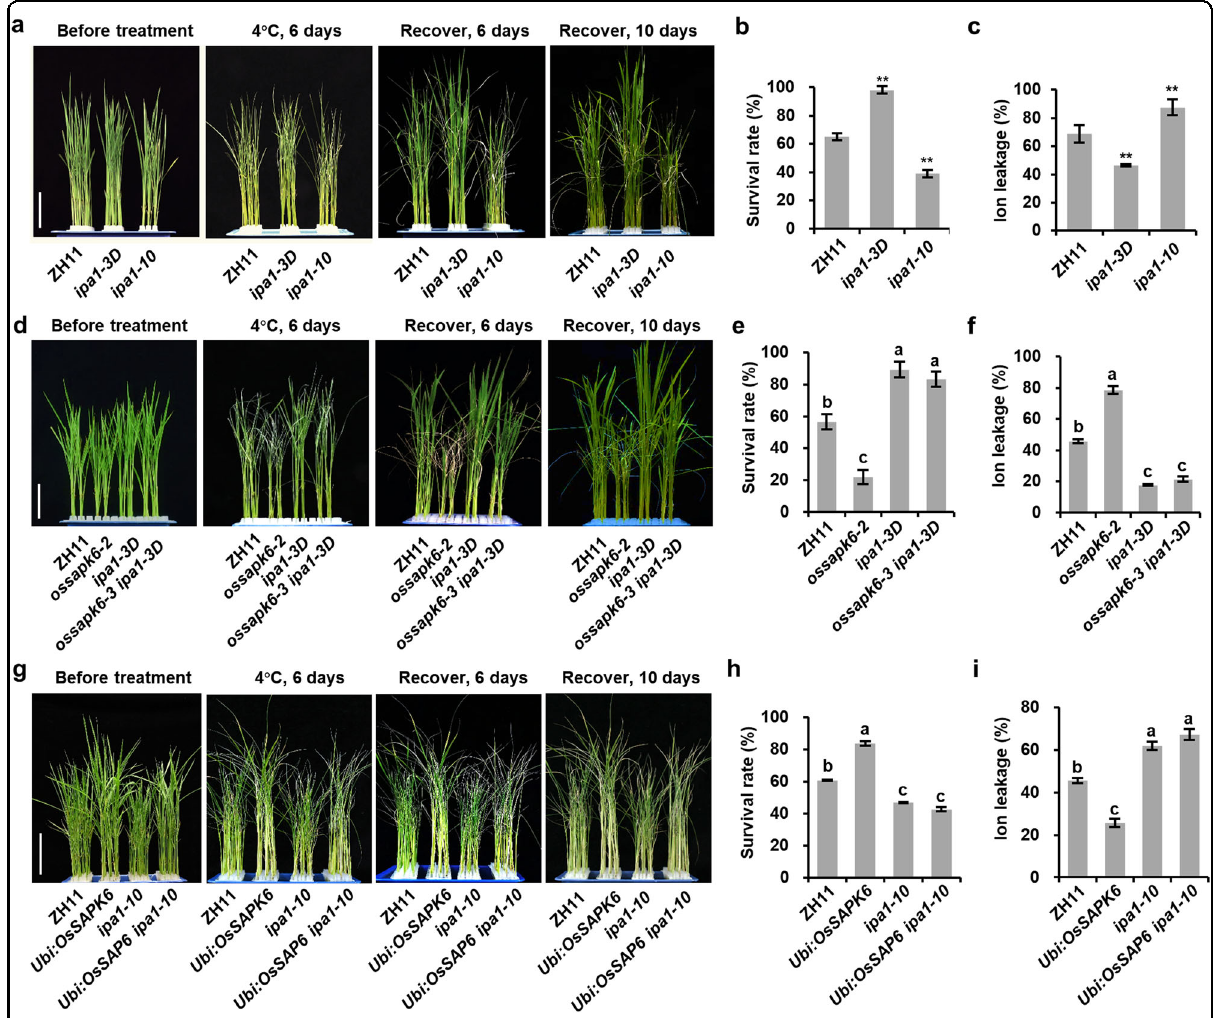
Fig. 4 The regulation of chilling tolerance by OsSAPK6 is dependent on IPA1. a Plant morphologies of 2-week-old ZH11, ipa1-3D and ipa1-10 seedlings before treatment, after 4 °C treatment for 6 days, and subsequent recovery for 6 or 10 days. b Survival rates of ZH11, ipa1-3D and ipa1-10 after 4 °C treatment as shown in a . c Ion leakage levels of ZH11, ipa1-3D , and ipa1-10 after 4 °C treatment for 6 h. d Plant morphologies of 2-week-old ZH11 , ossapk6-2, ipa1-3D , and ossapk6-3 ipa1-3D seedlings before treatment, after 4 °C treatment for 6 days, and subsequent recovery for 6 or 10 days. e Survival rates of ZH11 , ossapk6-2 , ipa1-3D, and ossapk6-3 ipa1-3D after 4 °C treatment as shown in d . f Ion leakage levels of ZH11, ossapk6-2 , ipa1-3D and ossapk6-3 ipa1-3D after 4 °C treatment for 6 h. g Plant morphologies of 2-week-old ZH11 , Ubi:OsSAPK6 , ipa1-10 , and Ubi:OsSAPK6 ipa1-10 seedlings before treatment, after 4 °C treatment for 6 days, and recovery for 6 or 10 days. h Survival rates of ZH11 , Ubi:OsSAPK6 , ipa1-10, and Ubi:OsSAPK6 ipa1-10 after 4 °C treatment as shown in g . i Ion leakage levels of ZH11, Ubi:OsSAPK6, ipa1-10 , and Ubi:OsSAPK6 ipa1-10 after 4 °C treatment for 6 h. Values are means ± SD ( n = 3 biological replicates). In b and c , the asterisks indicate signi fi cant differences compared with ZH11 (** P < 0.01, Student ’ s t -test). In e , f , h , and i , the different letters indicated signi fi cant differences ( P < 0.01) according to Tukey ’ s HSD test. Bars = 5 cm in a , d and g . See also Supplementary Fig.